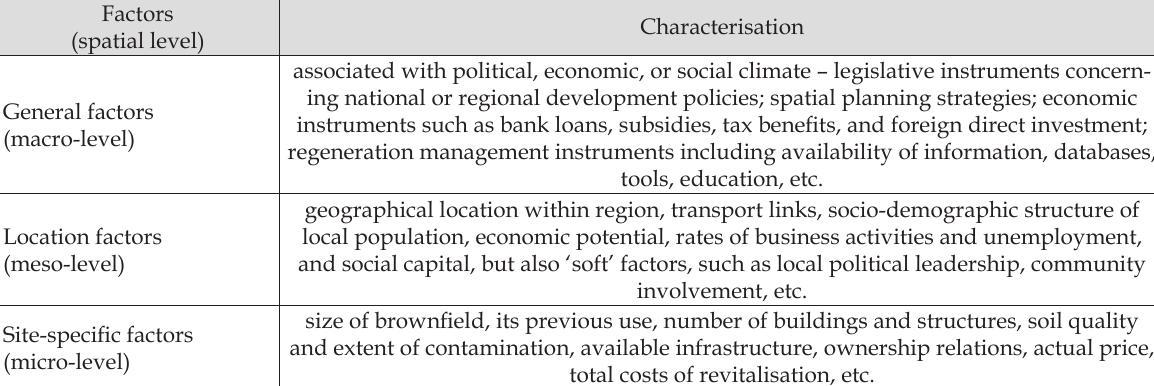
Table 1. Spatial scale of success factors of brownfield